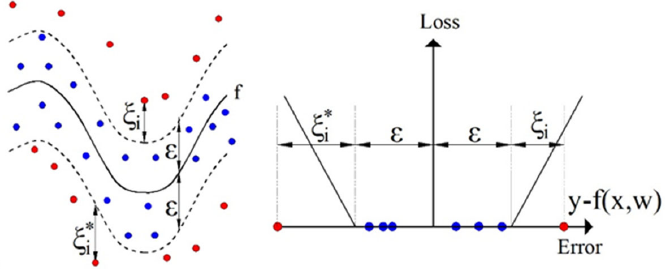
and the observed value is less than some value ε (Figure 5).